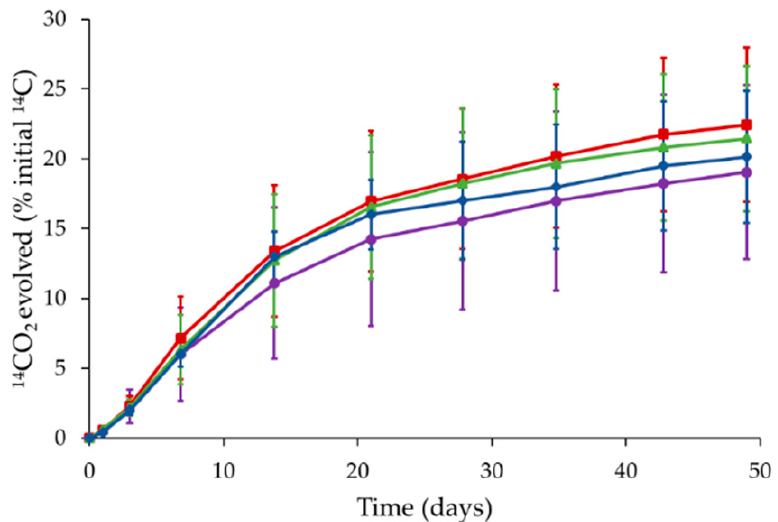
Figure 1. Mineralisation kinetics of isoproturon in control and compost amended soils, not compacted and compacted: Control (unamended), Compaction; Compost amended, No compaction; Compost amended, Compaction; Control (unamended), No compaction.